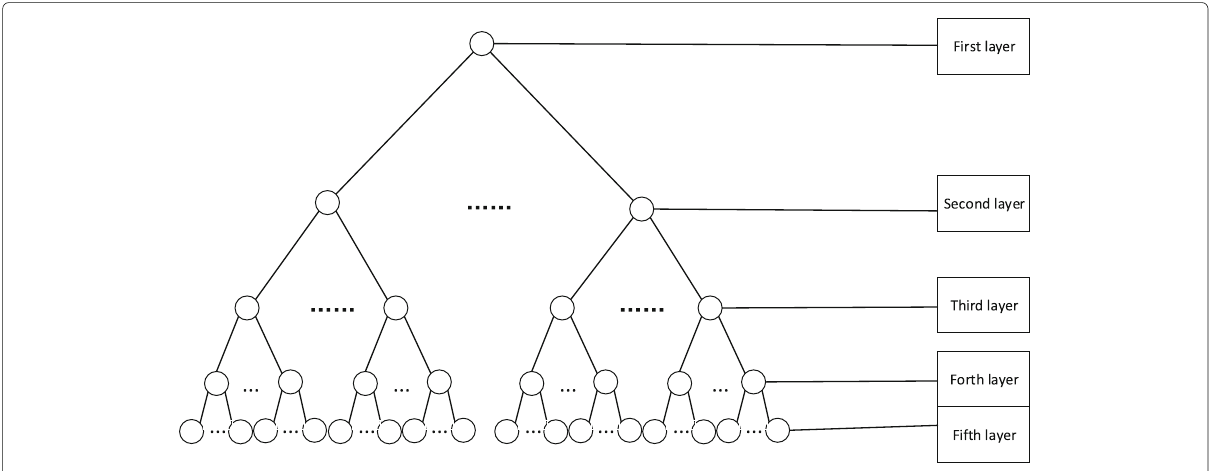
Fig. 2 Hierarchy structure of “Tong YiCi